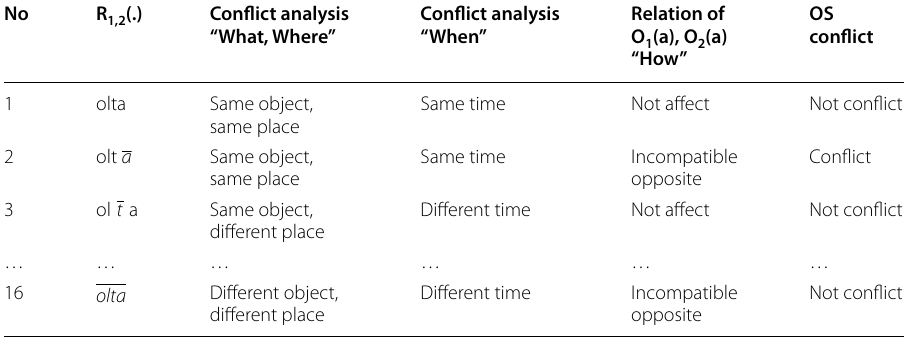
Table 1 Objective of states conflict analysis results No R 1,2